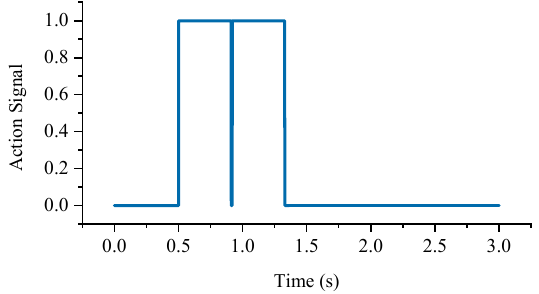
Figure 7. Action signal curve of active crowbar protection circuit.